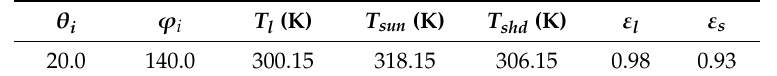
Table 2. Input parameters of simulation scene other than row structure.